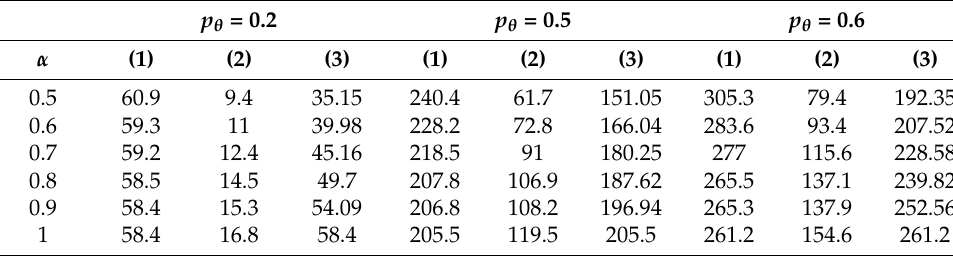
Table 9. Averages of TWWT , TWCTD and objective function, for different values of α and p θ